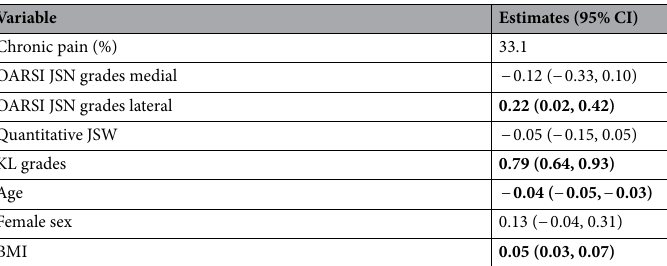
Table 2. Logistic regression model results for the association between chronic knee pain and radiological features including KL grades, OARSI JSN grades for lateral and medial compartments, and the minimum medial JSW measurement. In adjusted logistic regression analysis for ages, gender, and BMI, KL grades (OR 2.20; 95% CI 1.91, 2.52) and OARSI JSN grades for the lateral compartment (OR 1.24; 95% CI 1.02, 1.51) were statistically significantly associated with higher odds of chronic pain. The test sensitivity, specificity, and AUC respectively, of 0.80 (95% CI 0.77, 0.83), 0.55 (95% CI 0.50, 0.59), and 0.69 (95% CI 0.66, 0.71). Bold p-values are significant (p-value <